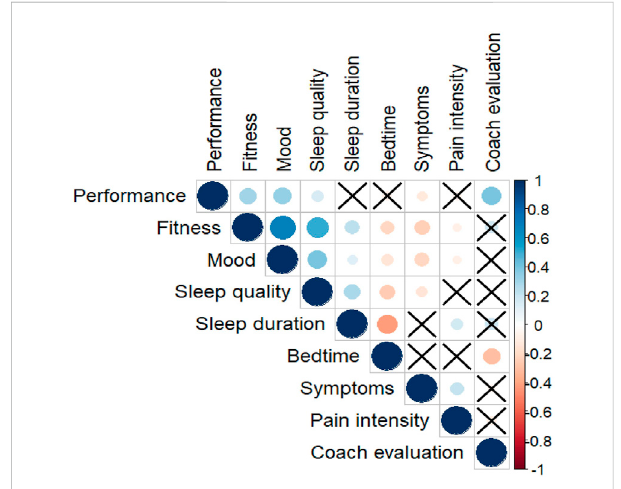
FIGURE 5 Correlations between the variables monitored during the daily follow-up. A correlation signi fi cantly different from zero is indicated by a circle (blue if positive and orange if negative) between a pair of variables. The larger thecirclethegreater thecorrelation. Across indicates a non-signi fi cant